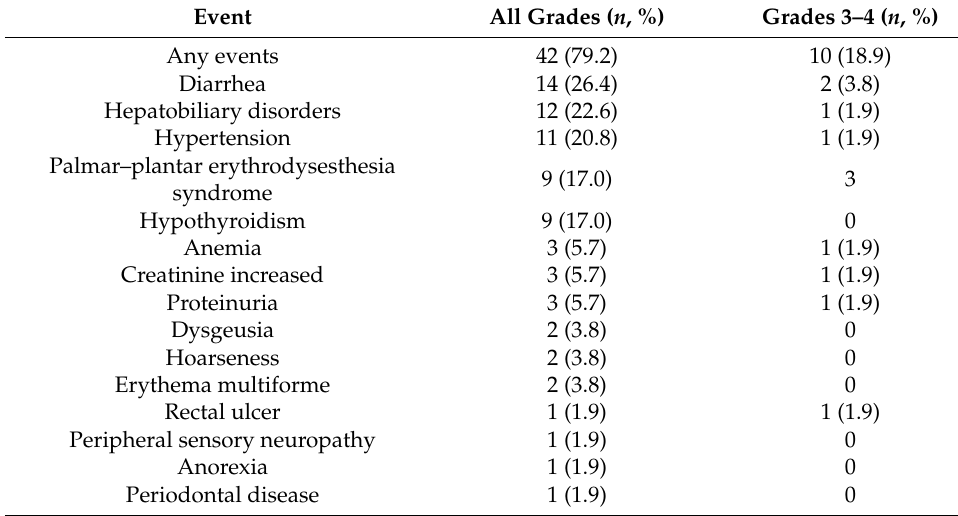
Table 4. Adverse events for